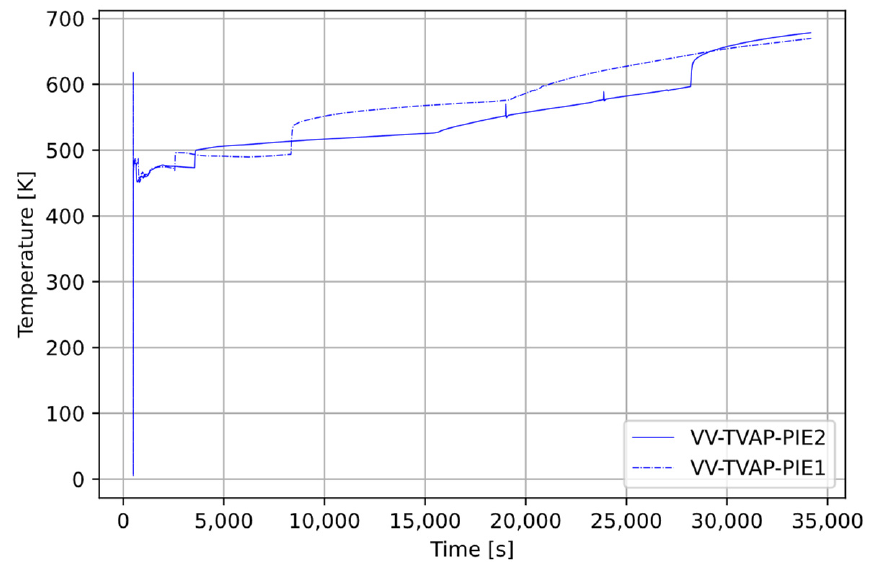
Figure 16. Vapor temperature transient in VV volume in PIE1 (dashed line) and PIE2 cases. Long-term H2 mass inventory resulting from steam_W reactions (W + 3 H2O –> 3 H2 + WO3 − 156 kJ/mol [23]) is shown in Figure 17a (PIE1) and in Figure 17b (PIE2), as mobilized from the VV to the connected volumes in Figure 18a (PIE1) and in Figure 18b (PIE2). At simulation end time, the cumulative H2 in the VV and VV ports is 0.53 kg (PIE1)/0.96 kg (PIE2), while it is 1.10 kg (PIE1)/1.07 kg (PIE2) in the VVPSS and BL/RD. The total H2 production until simulation end time (32 h) amounts to 1.64 kg (PIE1)/2.03 kg (PIE2), well below the 12 kg of H2 production limit currently adopted as the acceptance criterion in DEMO. Such a value, derived as a volume-based scaling from the ITER plant, is the maximal amount allowed such that a possible resulting explosion would not exceed the VV design pressure, fixed at 2